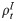
Comparison of the fraction of diseased individuals ρtI when κ = 0 and κ = 0.5 ((a),(b)).Different color lines stand for different community size c in the network. Furthermore, we also illustrate the incidence difference ϕi,j between community Ci and community Cj for different parameter κ in panel (c). The network size of two layers both are 1000. We fix the other two parameters as: β = 0.3, γ = 0.2.